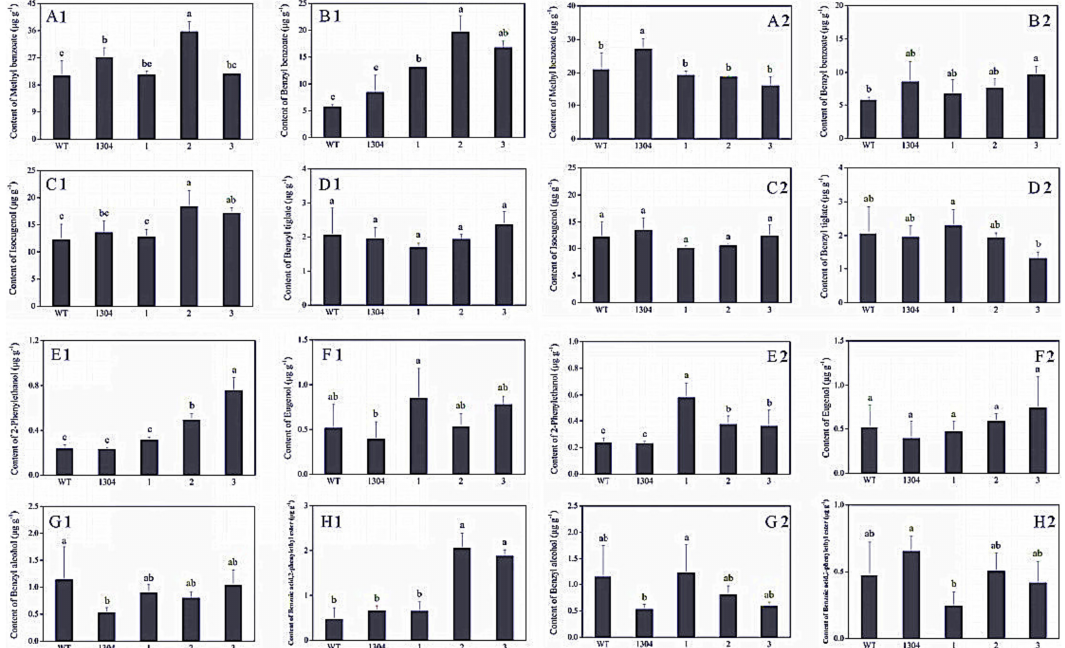
Figure 7. Analysis of the main volatile components in flower of Petunia . (A1–H1) Main volatile components of RrAADC transgenic and control plants; (A2–H2) main volatile components of RrAAAT transgenic and control plants; ( A ) methyl benzoate; ( B ) benzyl benzoate; ( C ) isoeugenol; ( D ) benzyl tiglate; ( E ) 2-phenylethanol; ( F ) eugenol; ( G ) benzyl alcohol; ( H ) benzoic acid, 2-phenylethyl ester; (WT) wild type; (1304) pCAMBIA1304 transgenic plants; (1–3) transgenic plants. ( ± SE, n =